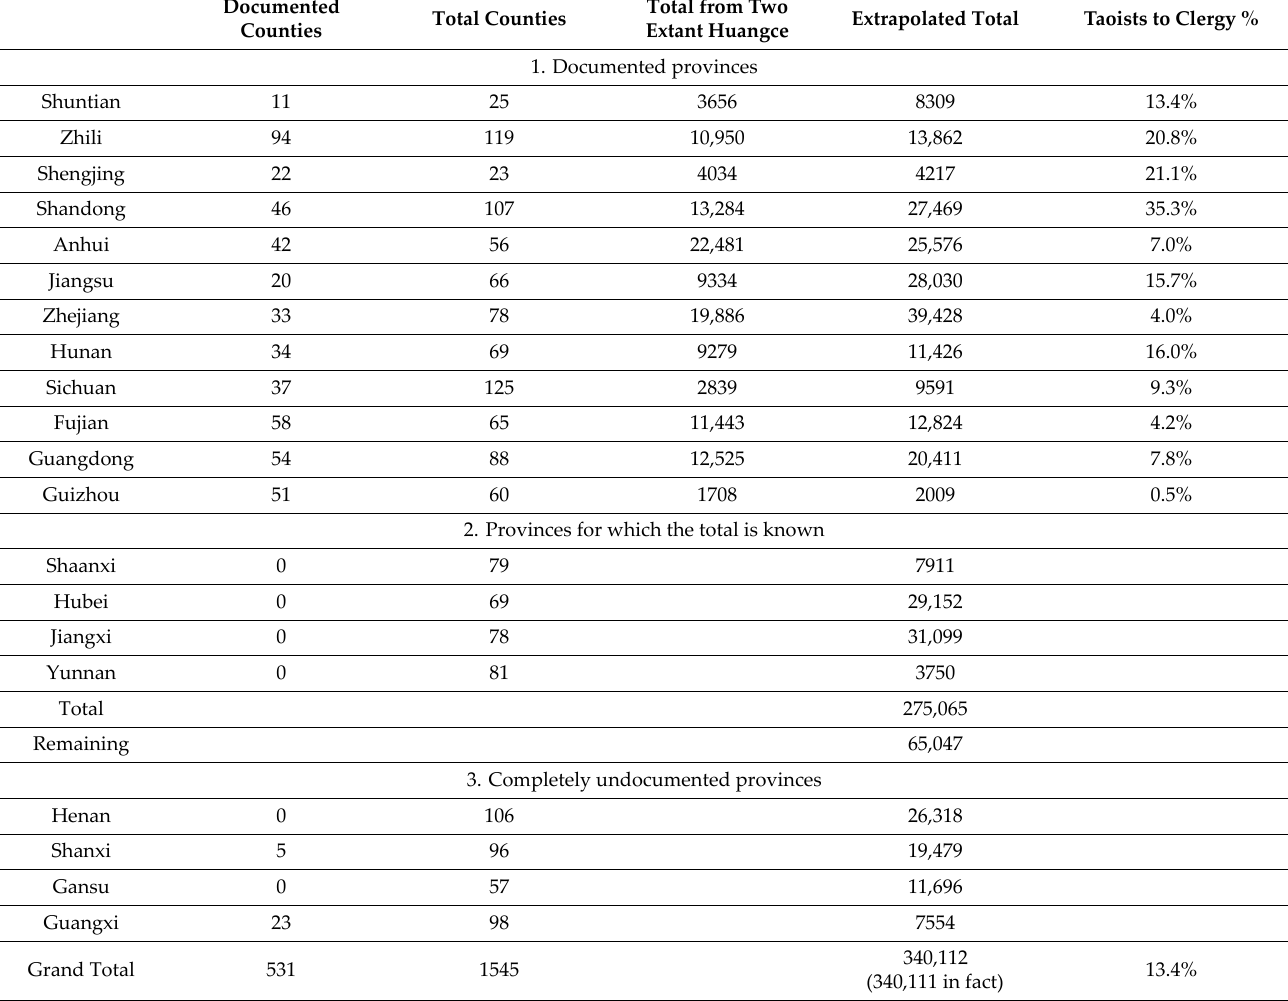
Table 1. Professor Goossaert’s estimated numbers of monks and Taoists in each province in 1737 and